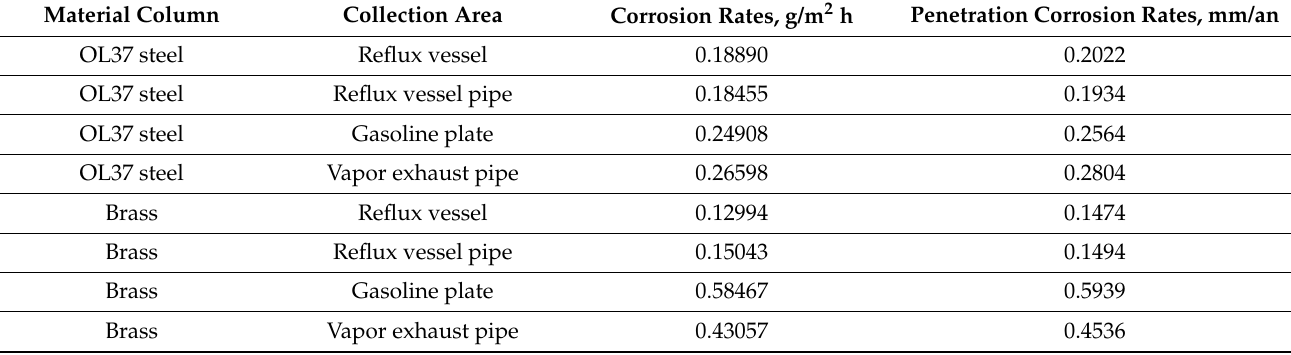
Table 4. Corrosion rate determined on samples collected from the top and bottom of the distillation